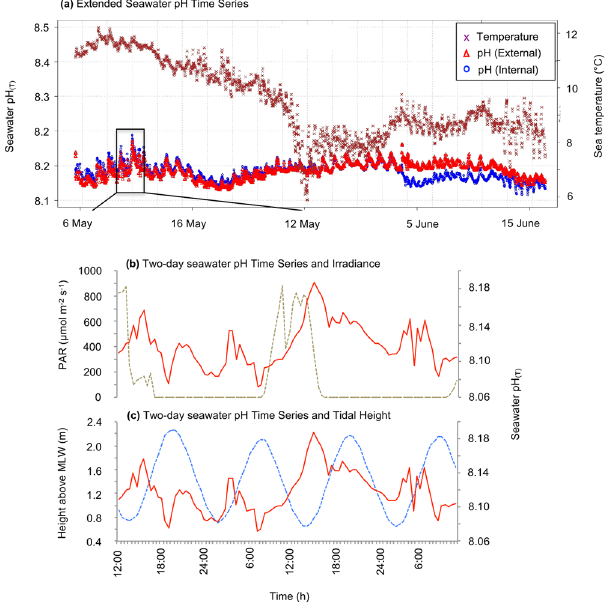
Figure 1. ( a ) Seawater pH (T) and sea temperature (°C) from 42-day deployment of the SeaFET at Portobello Marine Lab (PML) Wharf, Otago Harbour at 1 m depth. ( b ) Seawater pH and PAR (photosynthetically active radiation, 700–400 nm) light time series at PML from 9 to 11 May 2015. ( c ) Seawater pH and tidal height time series at PML from 9 to 11 May 2015. The pH (Internal) and pH (External) are the internal and external reference electrode measurements, respectively, which are equivalent when the instrument is correctly calibrated for accurate